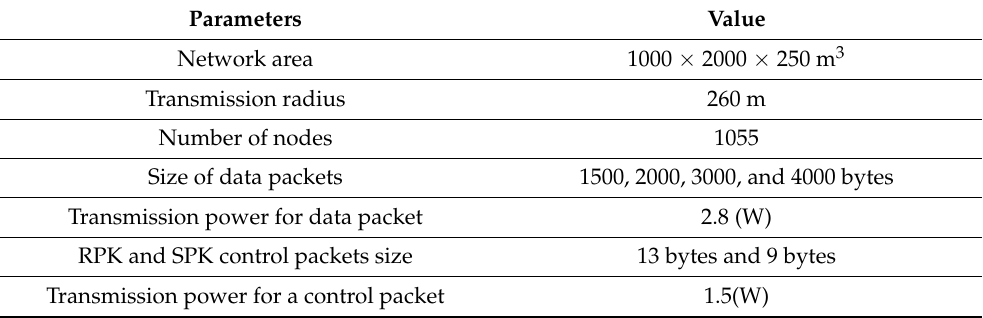
Table 1. Simulation parameters.